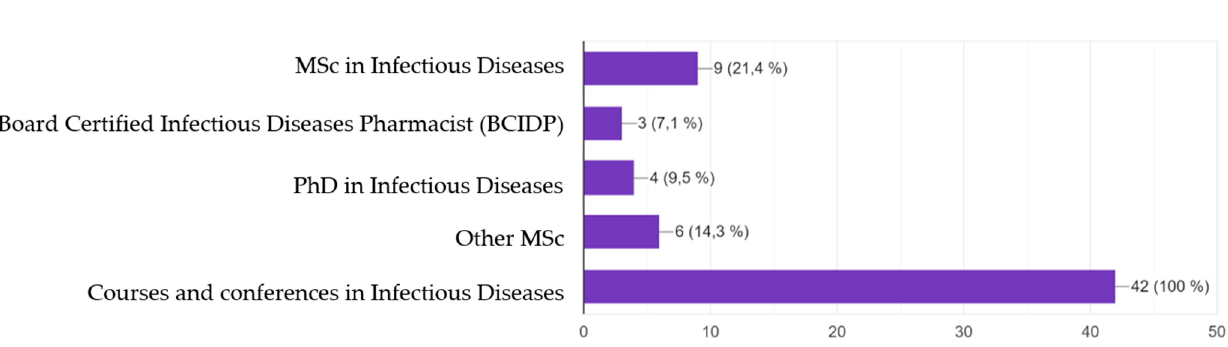
Table 2. Antimicrobial stewardship activities performed by clinical pharmacists according to the type of hospital.